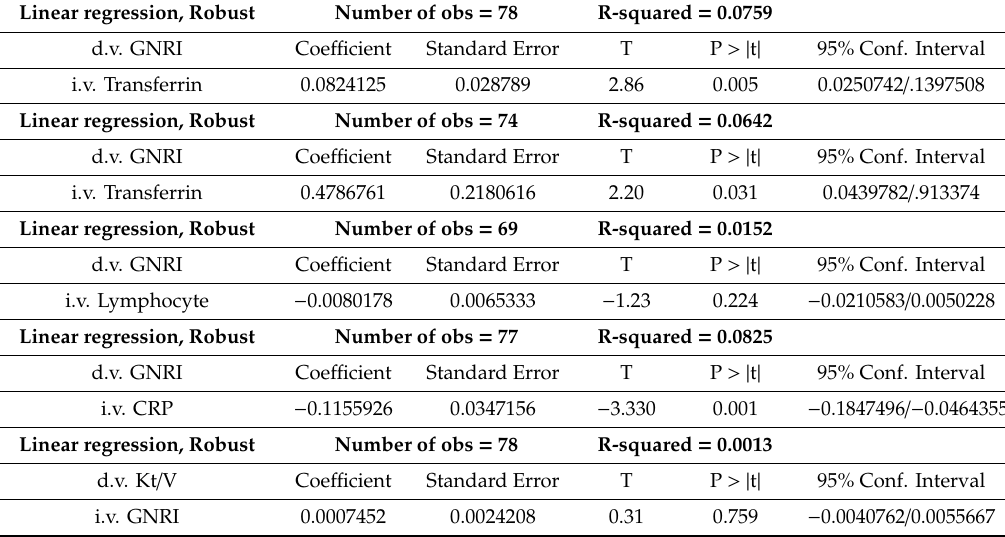
Legend to Table 2. Significant predictions are represented in bold; d.v., dependent variable; i.v., independent variable. The low R-squared in the presence of significance shows that even noisy, high-variability data can have a significant